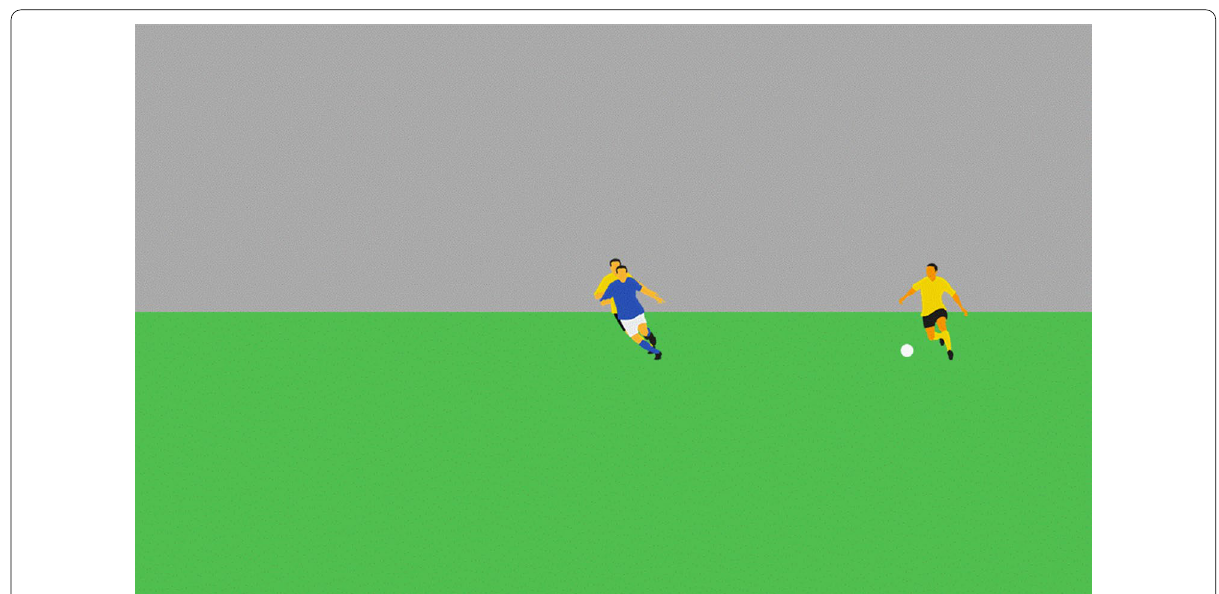
Fig. 5 Example of a display used in Experiment 2. In this display, the yellow team (resembling Borussia Dortmund) attacks from right to left. The position of the blue defender defines the offside line. Thus, the yellow forward is in an offside